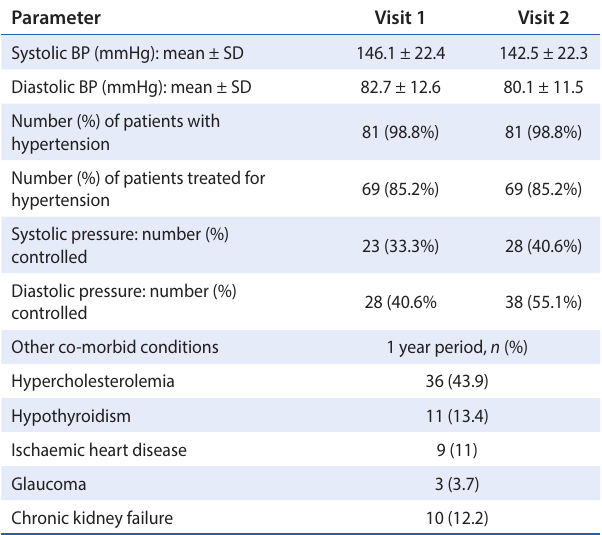
Table 5: Systolic and diastolic blood pressures, number (%) of patients with and number treated for hypertension, and number (%) systolic and diastolic pressures controlled and number (%) of patients with other co- morbid conditions